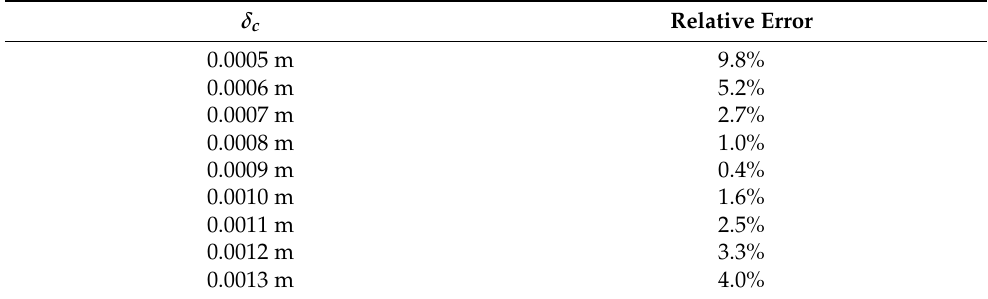
Table 4. Relative error of turbine outlet